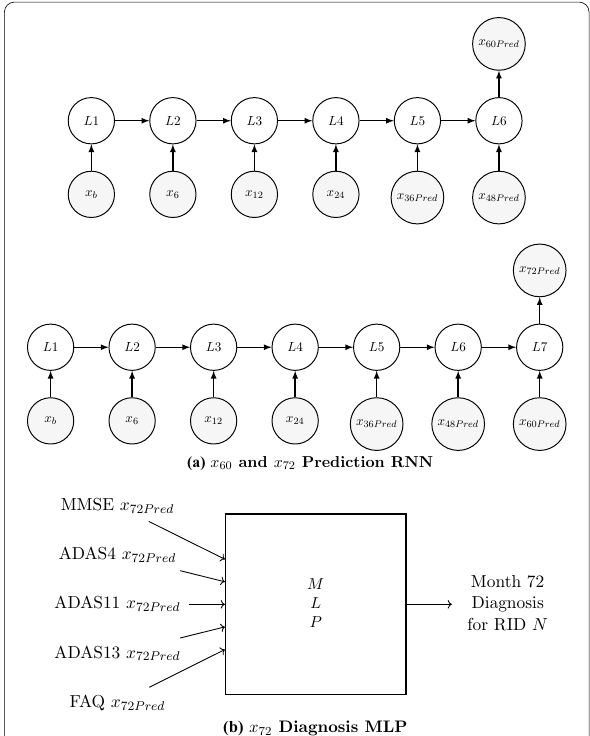
Fig. 2 72-month sequence prediction for a neuropsychological test for RID